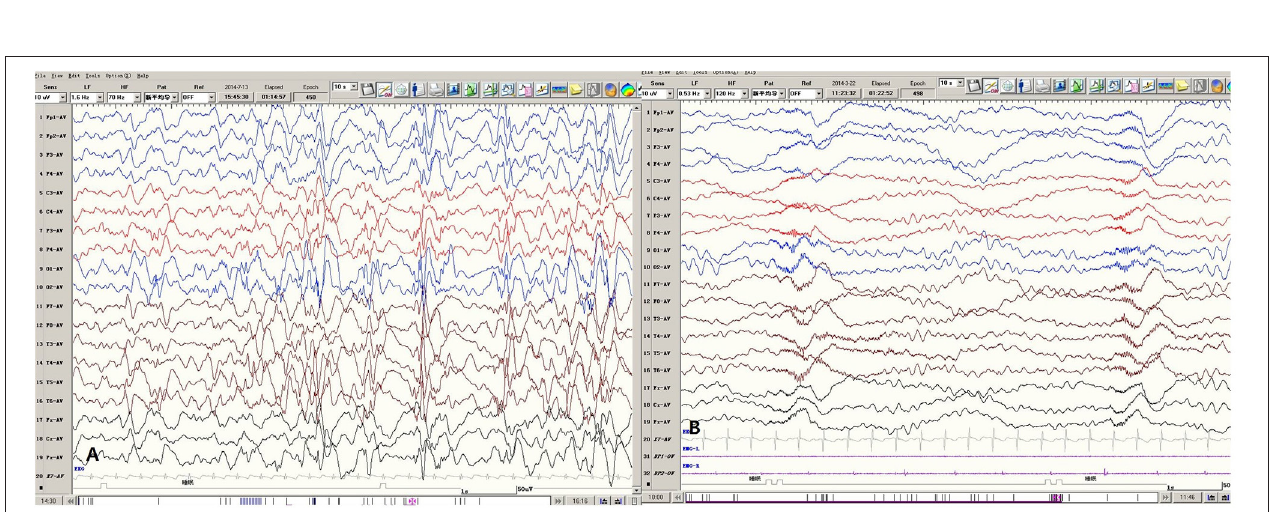
FIGURE 2 | Representative EEGs of Patient 1. (A) The Interictal hypsarrhythmia EEG pattern. (B) The ES ictal EEG pattern.